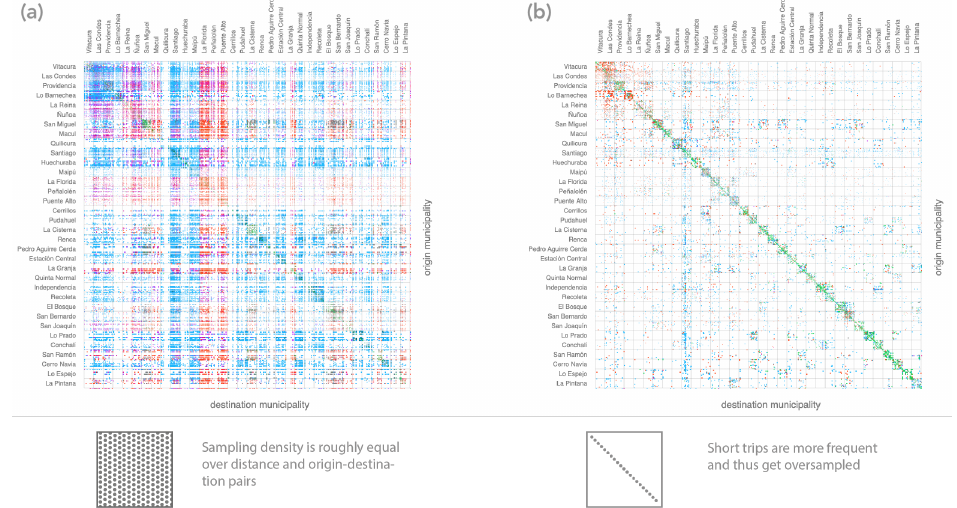
Figure 8. Zone-level OD matrix of XDR ( a ) and survey ( b ) flows for the night valley period. Sparser measures and an over representation of intramunicipal flows can be appreciated in the